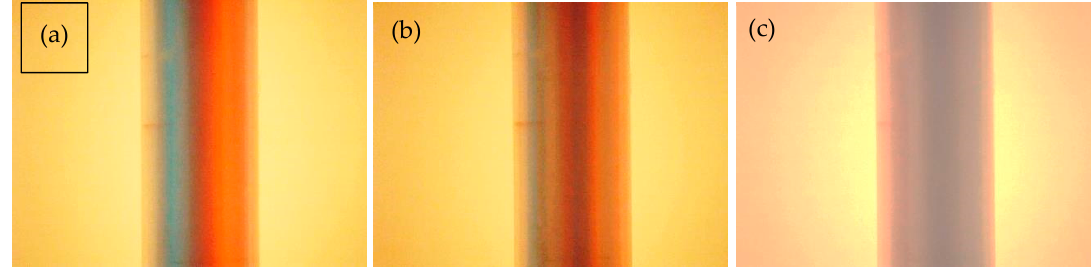
Figure 10. Mixing in T ‐ mixer at different volume flow rates: ( a ) 0.1 mL/min; ( b ) 5 mL/min; ( c ) 20 mL/min.